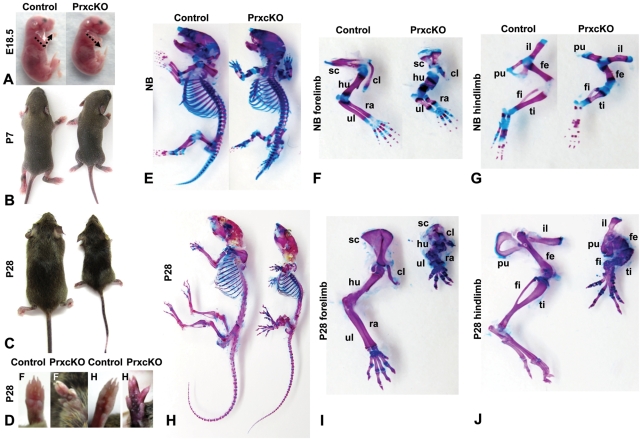
Phenotype of XPorcn-Ex3-7flox/Y;Prx-Cre mice.(A) Shortened forelimbs at E18.5 in XPorcn-Ex3-7flox/Y;Prx-Cre (PrxcKO) compared to wild type littermate (control). (B) Stunted growth at day 7 (P7) in PrxcKO compared to control littermate. (C) Appearance of PrxcKO compared to WT littermate at P28. (D) Digital abnormalities showing shortened limbs and shortened digits in PrxcKO compared to WT. F, forelimb; H, hindlimb. (E) Whole-skeleton preparations of newborn mice (NB). Mutant exhibits shortening of all skeletal elements. (F, G) Skeletal preparations of NB forelimbs and hindlimbs. (H) Whole-skeleton preparations of P28 mice. Mutant exhibits more dramatic shortening of all skeletal elements. (I, J) Skeletal preparations of forelimbs (F) and hindlimbs (H) at P28. hu, humerus; ra, radius; sc, scapula; ul, ulna; cl, clavicle; il, ilium; pu, pubis; fe, femur; ti, tibia; fi, fibula.